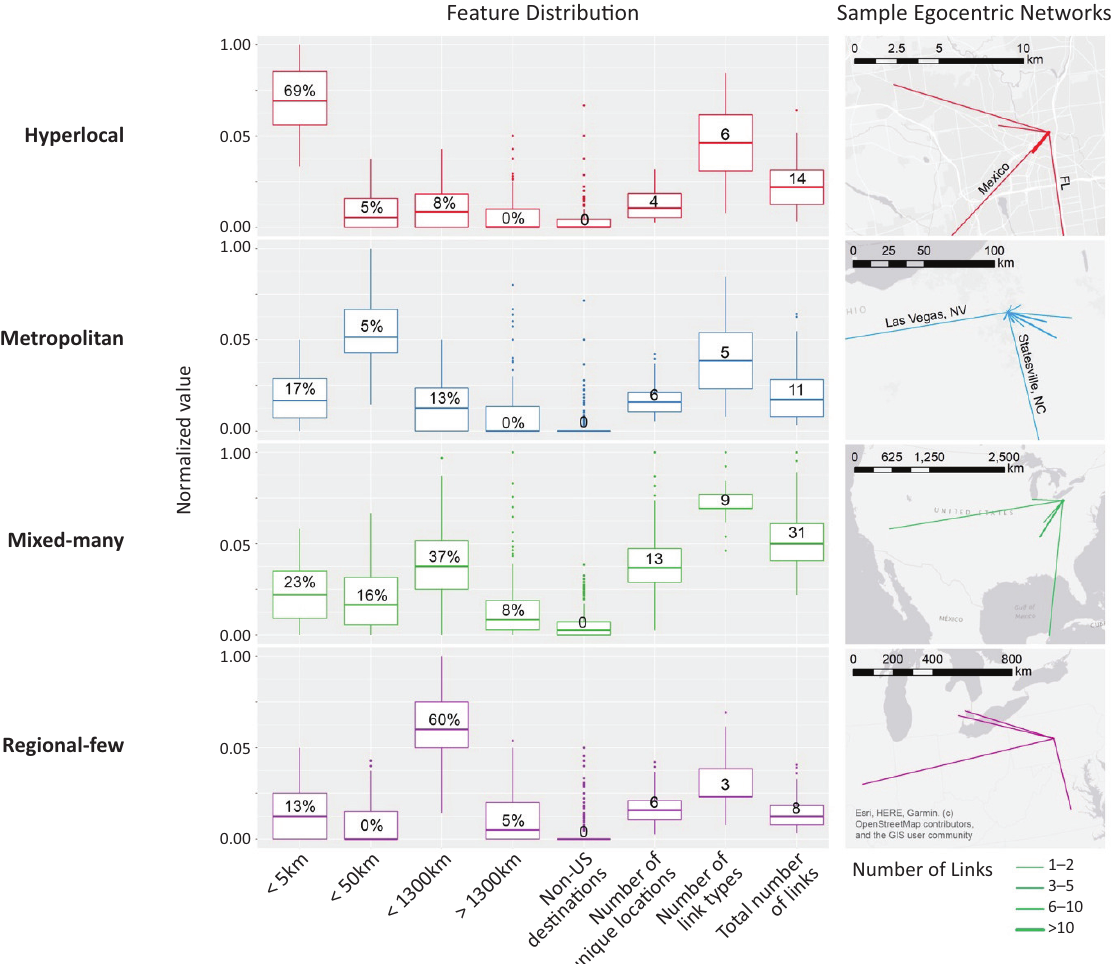
Figure 2. Boxplots and sampled ego‐centric networks from each of the four resulting clusters. Notes: The boxplot shows the descriptive statistics of each feature in each cluster; for non‐distance features, the boxplots report the distribution of absolute counts; for distance‐related features, the boxplots report the distribution of the percentage of links in the dis‐ tance ranges rather than absolute counts. The labeled statistics on the boxplots are the unscaled median values for each feature; the y values are then scaled between 0 and 1 for relative comparison. The sampled networks on the right provide examples of scale, wherein the edges are weighted by the number of links connected to each